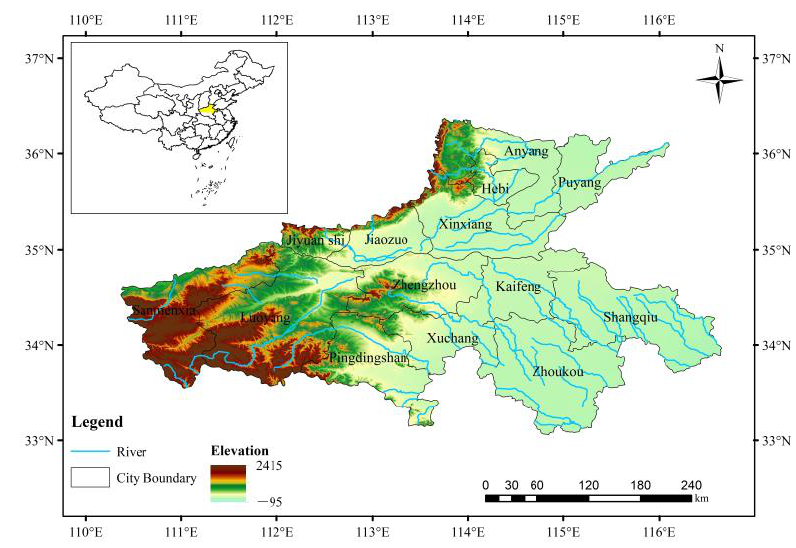
Figure 3. Schematic diagram of the location of the study area.